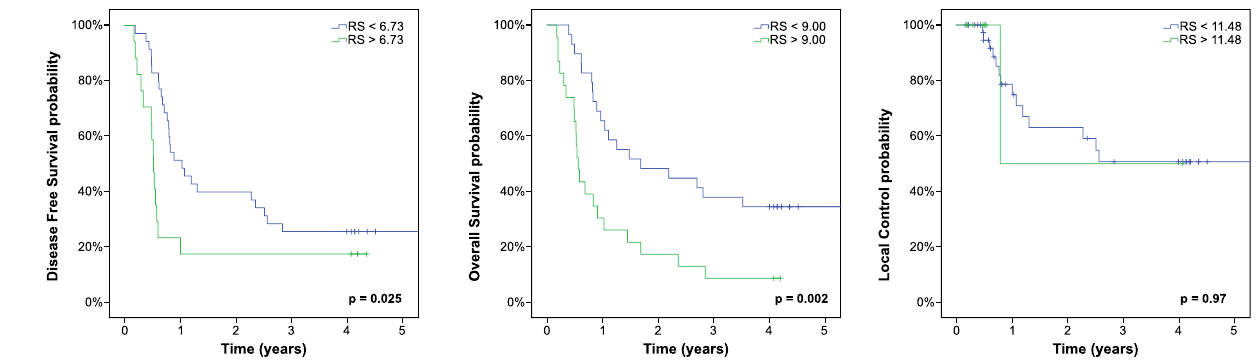
Figure 2. Internal validation cohort. Kaplan–Meier estimates with prognostic groups split by endpoint-specific radiomics signatures (RS) into high and low-risk endpoints (OS and LC). The inability to validate all signatures might be due to small group sizes (especially in the external validation cohort) and a relatively large number of intercurrent deaths within the internal validation cohort hampering validation of the LC signature. Nonetheless it is remarkable that it was feasible to confirm a radiomics signature for DFS.